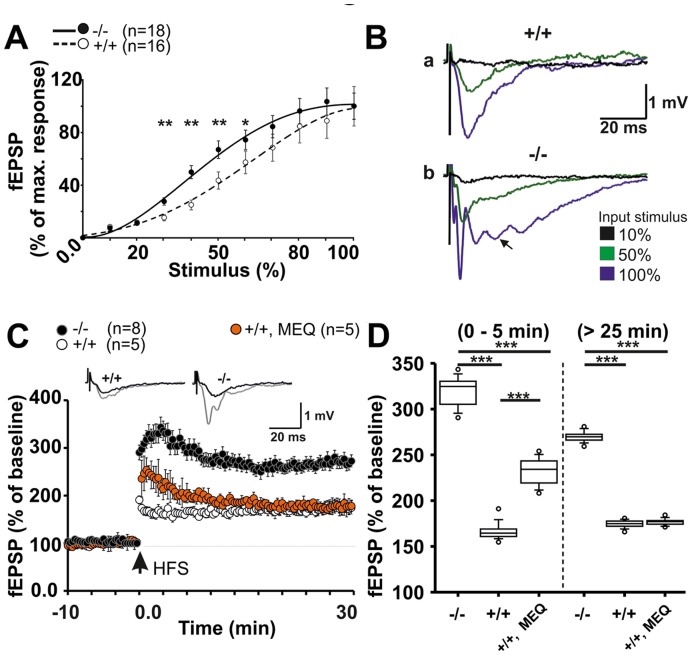
Loss of Panx1 alters postsynaptic responses in the hippocampal CA1 area.a, IO-relations demonstrate increased excitability of acute Panx1−/− hippocampal slices (−/−, solid line; +/+, dashed line). b, fEPSP sample traces at 10, 50, 100% of the maximum input stimulus intensity. At high input stimuli, a characteristic oscillatory component appears in Panx1−/− but not Panx1+/+ mice. c, Panx1−/− animals show increased LTP responses during the early (0–5 min) and persistent phase (25–30 min). Insets in (C) depict sample traces before (black) and 30 min post (grey) high frequency stimulation (HFS). Note that inhibition of Panx1 by 50 nM mefloquine (MEQ) does not fully emulate the knock out effect. c, Comparing fEPSP amplitudes reveals significant increased early and persistent LTP in Panx1−/− slices. MEQ does not reconstitute the Panx1+/+ response to Panx1−/− levels. Statistics: (a) two tailed Mann-Whitney test (non-parametric), (c) ANOVA (early: F3,64 = 573.7; P<0.0001; late: F3,64 = 259.1; P<0.0001) and Holm-Sidack post-hoc test.